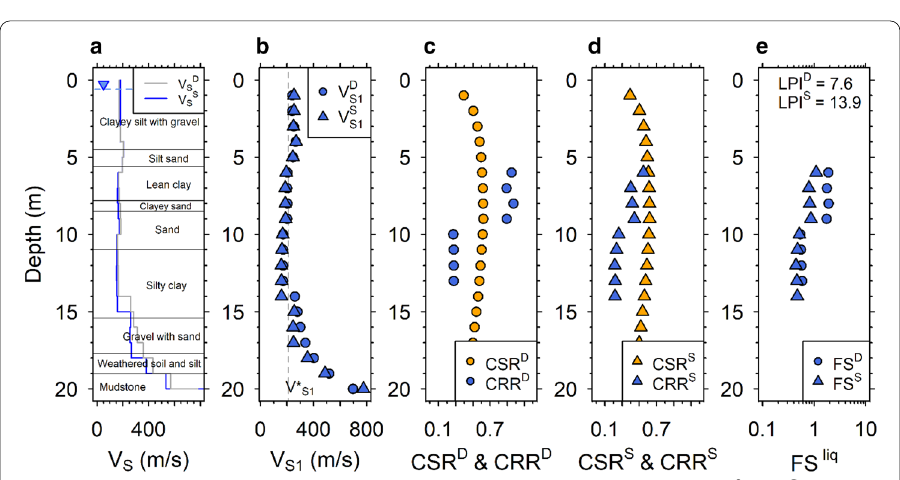
Fig. 4 Profiles of a raw V S measured from the downhole test and suspension PS logging ( V S S and V S D , respectively); b V S 1 ; c cyclic stress ratio and cyclic resistance ratio by the downhole test (CSR D and CRR D , respectively); d cyclic stress ratio and cyclic resistance ratio by suspension PS logging (CSR S and CRR S , respectively); and e FS liq by downhole test and suspension PS logging (FS D and FS S , respectively) at Site 2, where sand boils were observed (liquefied site). The LPI is shown at the top right of ( e ). The sand at a depth